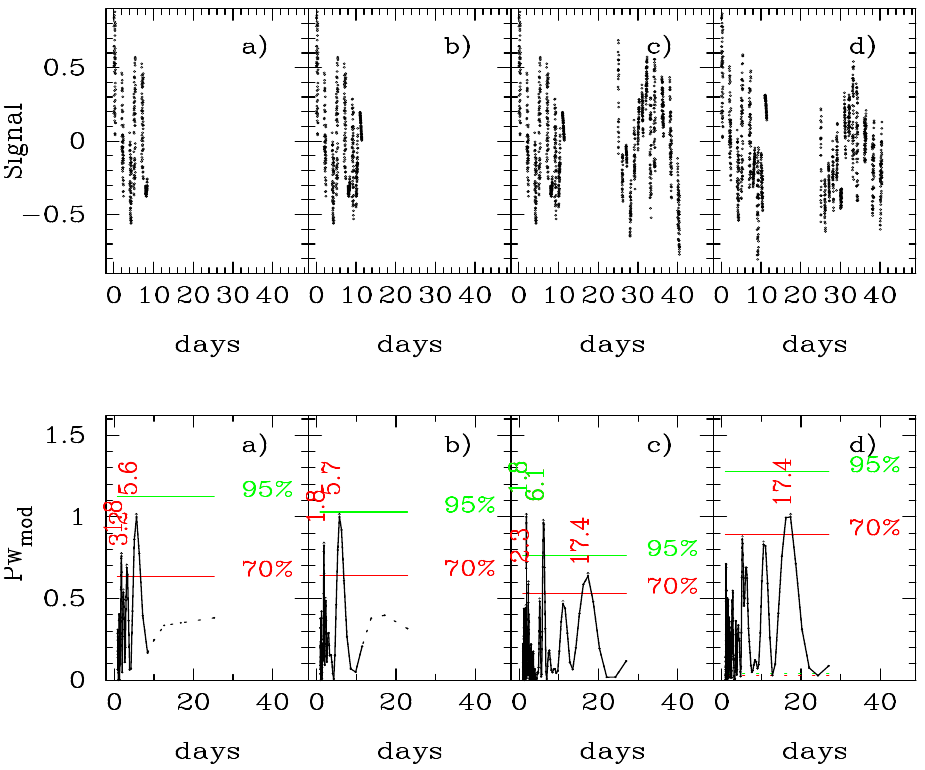
Fig. A3. Upper panel: Simulations of periodic signals of 1.8, 6.2, 11.2 and 16.5 days of periods plus noise. Simulations: (a) , (b) , (c) , and (d) see text for details. Lower panel: